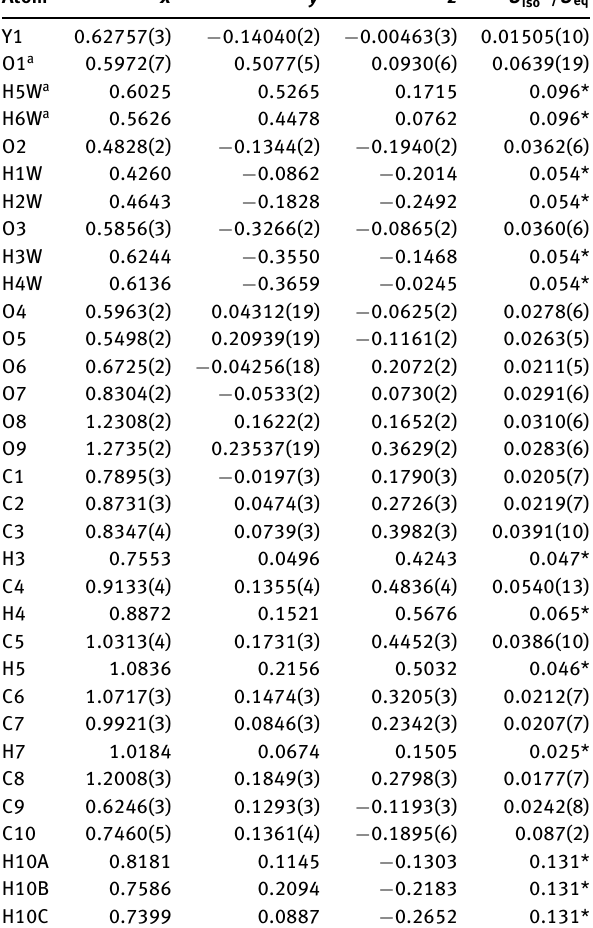
Table 2: Fractional atomic coordinates and isotropic or equivalent isotropic displacement parameters (Å 2